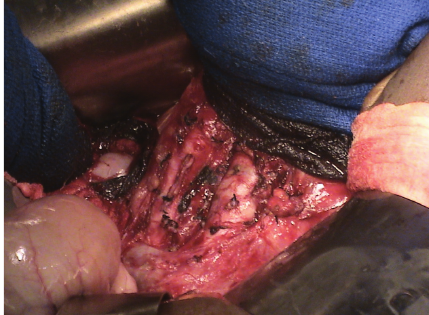
Figure 3: Paraganglioma shown at 10x magnification with Ki-67 staining demonstrating a low proliferative index. Image courtesy of Tulane University School of Medicine, Department of Pathology .